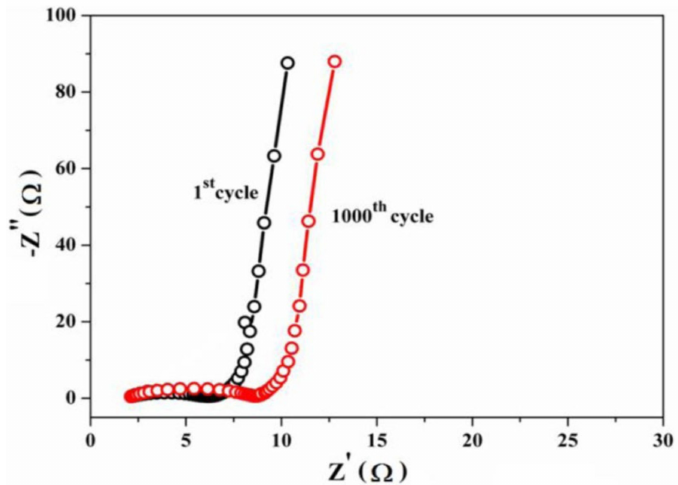
Figure 15. Nyquist plots of the PALF-AC electrode in the frequency ranging from 100 kHz to 10 mHz at open-circuit voltage with an AC perturbation of 10 mV. The EIS measurements were recorded during the cycle stability testing. Adapted with permission from Ref.